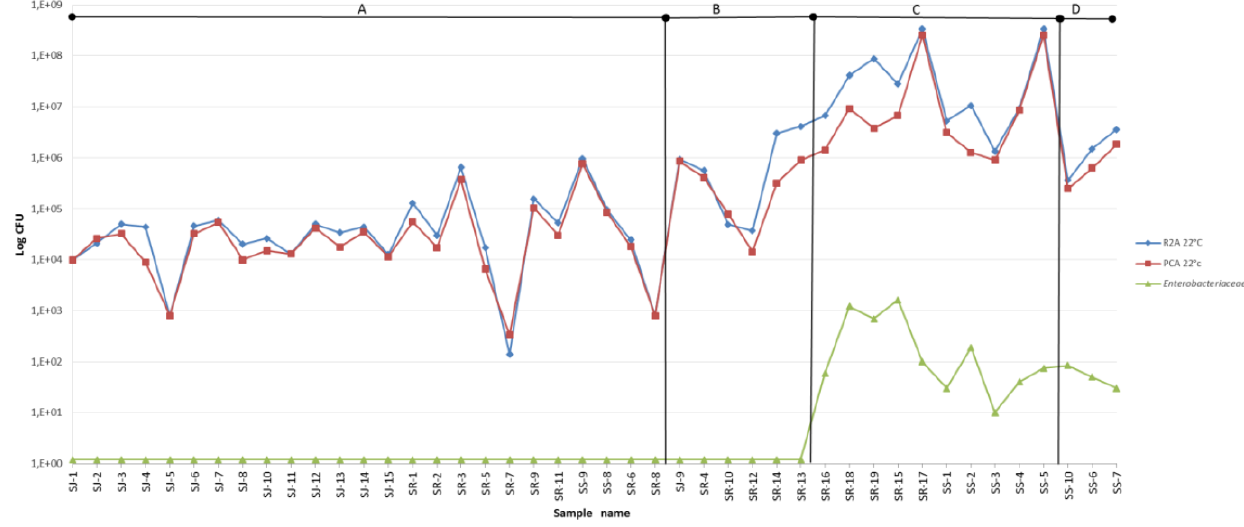
Figure 3. Total bacterial counts with the plate count agar method at 22 ◦ C. The blue diamonds show the total environmental bacterial counts with the plate count agar method and the red squares show the numbers grown on R2A media at 22 ◦ C. The number of Enterobacteriaceae in the soil samples are shown with green triangles. The sample order is oriented according to the appearance of the surface soil, starting with pure sand or pumice and in some cases with tiny vegetation (SR-9, SR-6) or bird droppings (SS-9, SS-8, SR-8) including sample SR-8 (a) , partly vegetation including sample SR-13 (b) , total vegetation with bird droppings including sample SS-5 (c) and sand with bird droppings including sample SS-10 (d) . See Fig. 1 for locations.